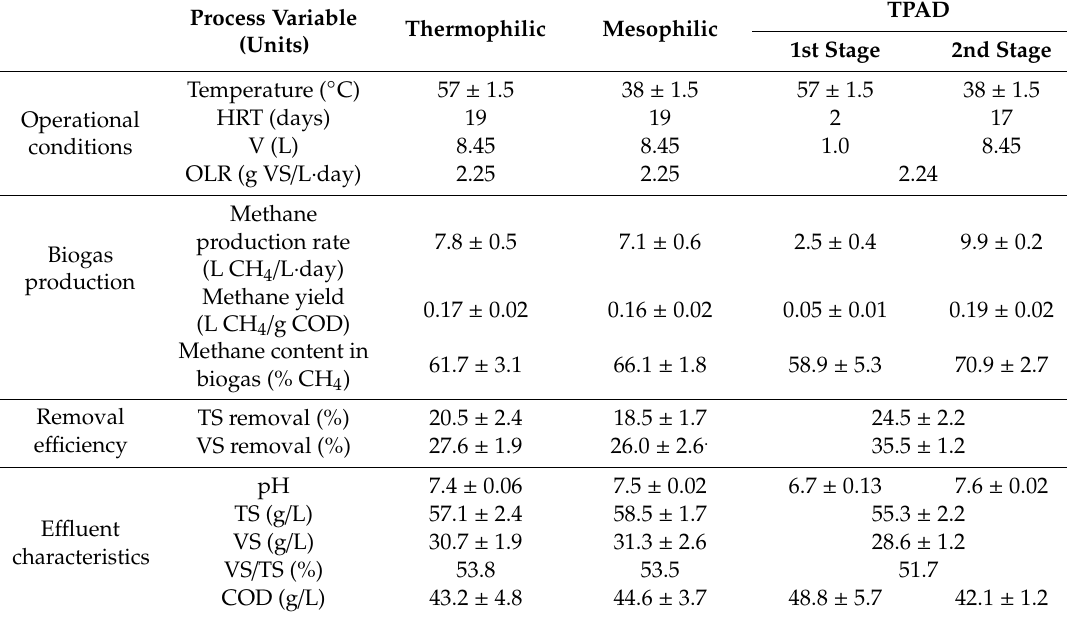
Table 1. Performance of the mesophilic, thermophilic and temperature-phased anaerobic digestion lab-scale systems. Values given as mean ± standard